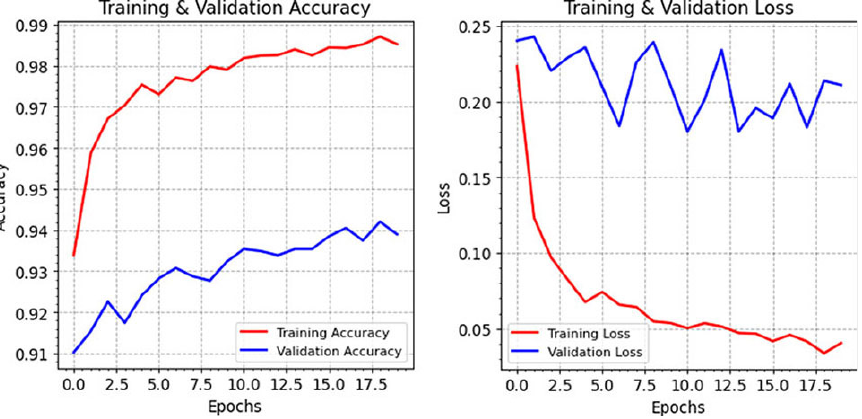
Fig. 3. Accuracy and loss of NASNetMobile model over twenty epochs